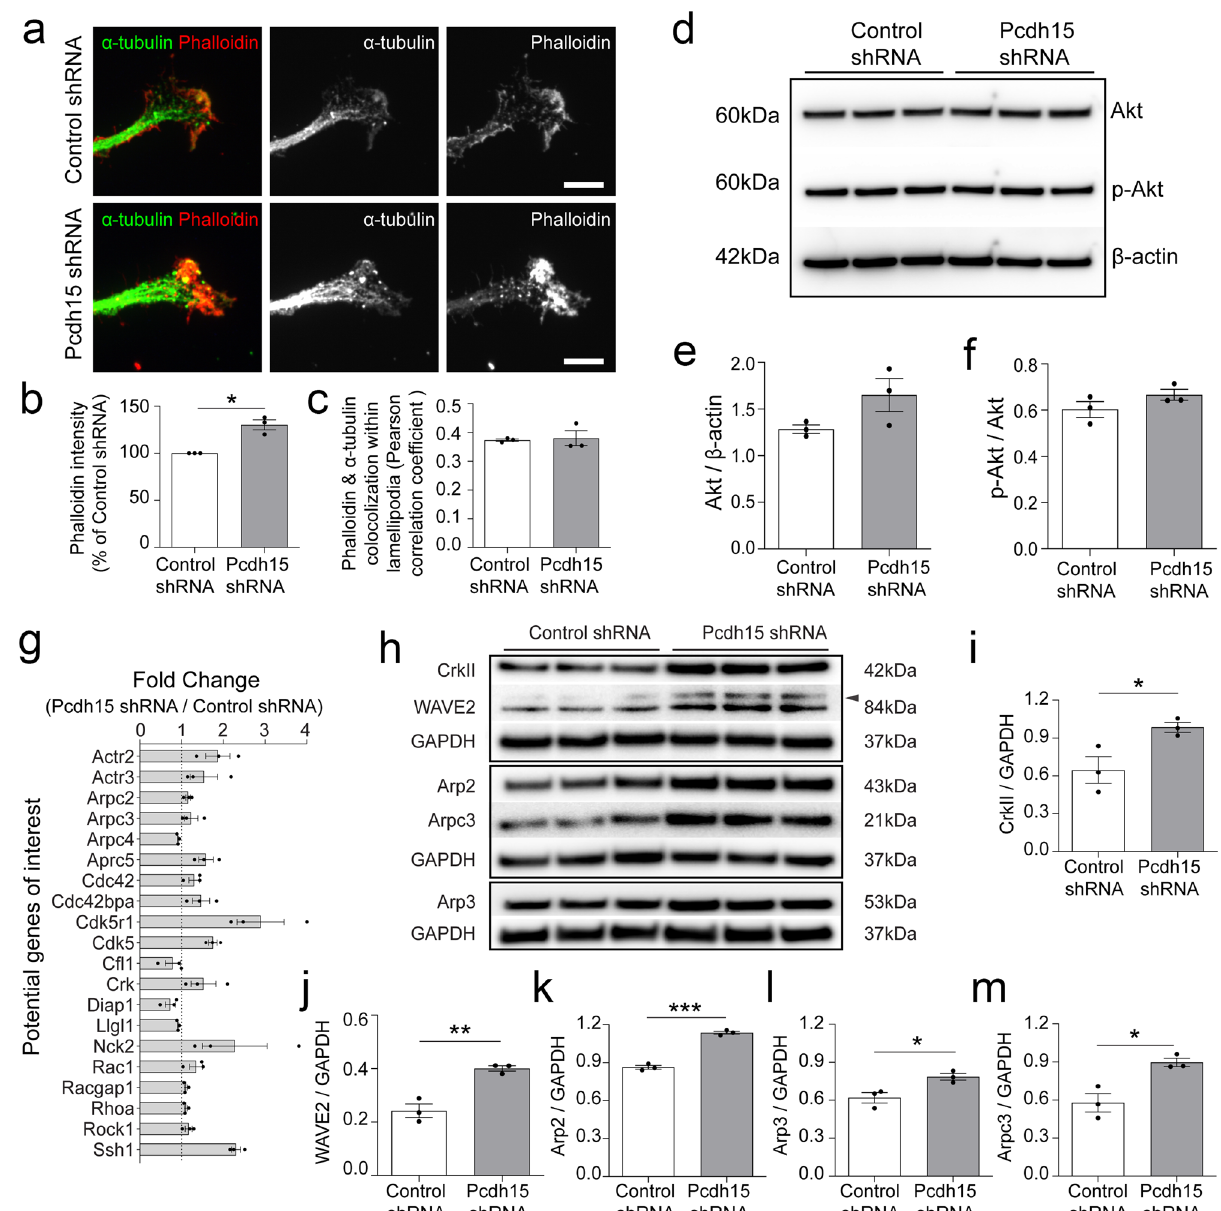
Fig. 7 Pcdh15 knockdown promotes F-actin accumulation in OPC veils and increases the expression of genes and proteins that enhance Arp2/3 activity. a Confocal images of OPC processes in control- and Pcdh15 shRNA treated cultures immunolabelled to detect microtubules ( α -tubulin, green) and F-actin (Phalloidin, red). b Quanti fi cation of phalloidin intensity (integrated pixel density) in control and Pcdh15-knockdown OPCs (normalized to the average intensity of control OPC cultures) ( n = 3 independent cultures, ≥ 51 veils analysed per condition; one-sample t -test for Pcdh15-shRNA: deviation from 100(%) = 30.25, SD of deviation = 9.19, t (2) = 5.697, p = 0.029). c Degree of colocalization between actin (phalloidin) and microtubule ( α -actin) labelling in control and Pcdh15 knockdown OPC veils. Colocalization is expressed as a Pearson correlation coef fi cient (mean ± SEM, n = 3 independent cultures, ≥ 37 veils measured per condition; unpaired t -test, p = 0.81). d Protein lysates from control and Pcdh15 knockdown OPCs analysed by Western blot to detect Akt, phosphorylated Akt (p-Akt) and β -actin. e Expression of Akt in control and Pcdh15 knockdown OPC cultures, normalised to β -actin expression (integrated pixel density measured for each protein band; mean ± SEM, n = 3 independent cultures; unpaired t -test, p = 0.12). f Quanti fi cation of p-Akt (Ser473) and Akt in control and Pcdh15 knockdown OPCs, normalised to β -actin (integrated pixel density measured for each protein band; mean ± SEM, n = 3 independent cultures; unpaired t -test, p = 0.20). g Average fold change in cytoskeletal gene expression between OPCs transfected with control- and Pcdh15 -shRNA (average from n = 3 independent cultures). h Protein lysates from control and Pcdh15 knockdown OPCs analysed by Western blot to detect CrkII and WAVE2, which are upstream of the Arp2/3 complex, Arp2, Arp3 and Arpc3, which are components of the Arp2/3 complex, and GAPDH. i CrkII, j WAVE2, k Arp2, l Arp3, and m Arpc3 protein expression was quanti fi ed by measuring the integrated pixel density of the corresponding Western blot band and normalising expression to GAPDH expression for each sample [mean ± SEM, n = 3 independent cultures, expression in control and Pcdh15 knockdown OPCs was compared by unpaired t -tests: i p = 0.039, j p = 0.004, k p = 0.0001, l p = 0.028, m p = 0.016]. Scale bars represent 5 µ m.